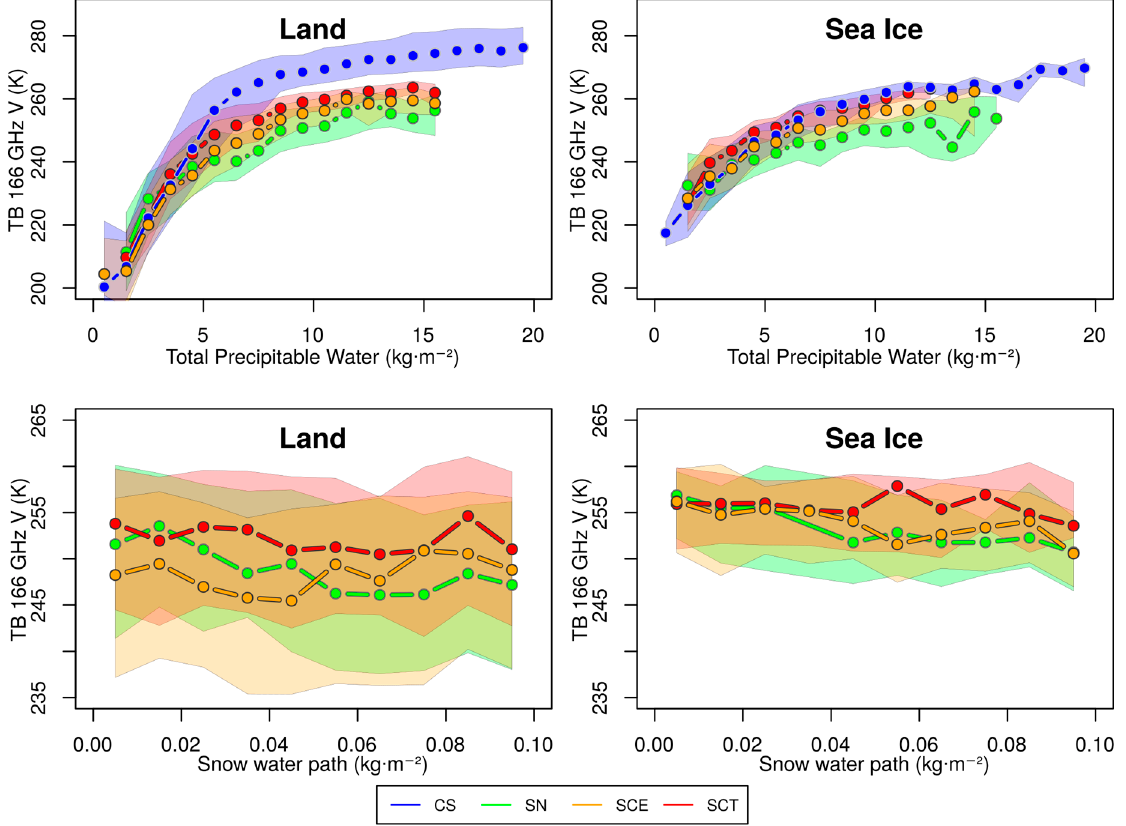
Figure 8. Median values of TBs at 166 GHz (V-pol) (computed in TPW and SWP bins) as functions of: TPW ( top ); and SWP ( bottom ) for clear sky (CS, blue), snow (SN, green), snow + embedded layer of supercooled (SCE, orange), snow+ supercooled layer on top (SCT, red). The colored shades represent the spread of the TBs between the 25th and 75th percentiles in each manifold. The dataset has been divided into 21 TPW bins (top) and 11 SWP bins (bottom), and only the results for bins with at least 20 pixels are shown (for statistical significance). Sea ice results are shown for SIC > 57%. In the bottom panels the results are shown for TPW > 3.6 kg·m − 2 over land, and for TPW > 5.1 kg·m − 2 over sea ice.